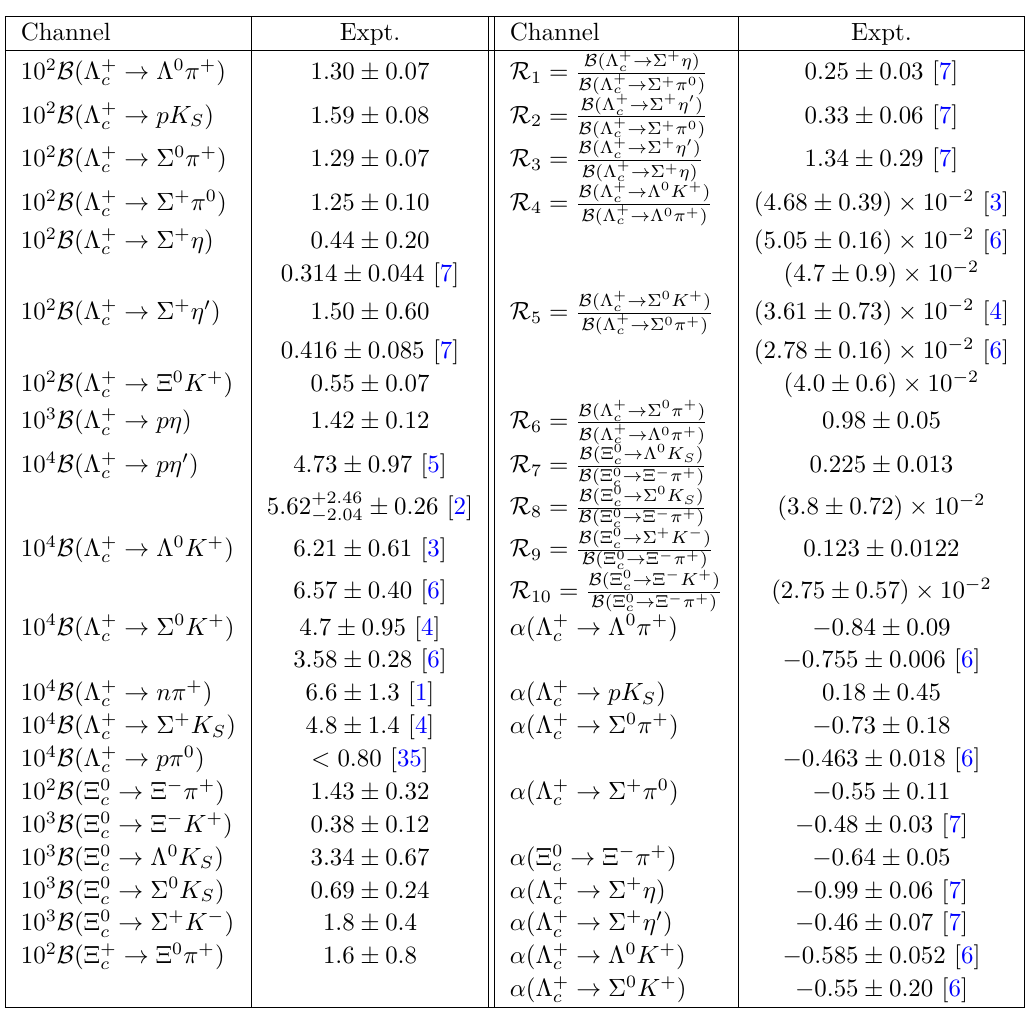
Table 4 . A summary of current experimental results, including branching fractions, branching fraction ratios and decay asymmetries. All the data without references is quoted from PDG